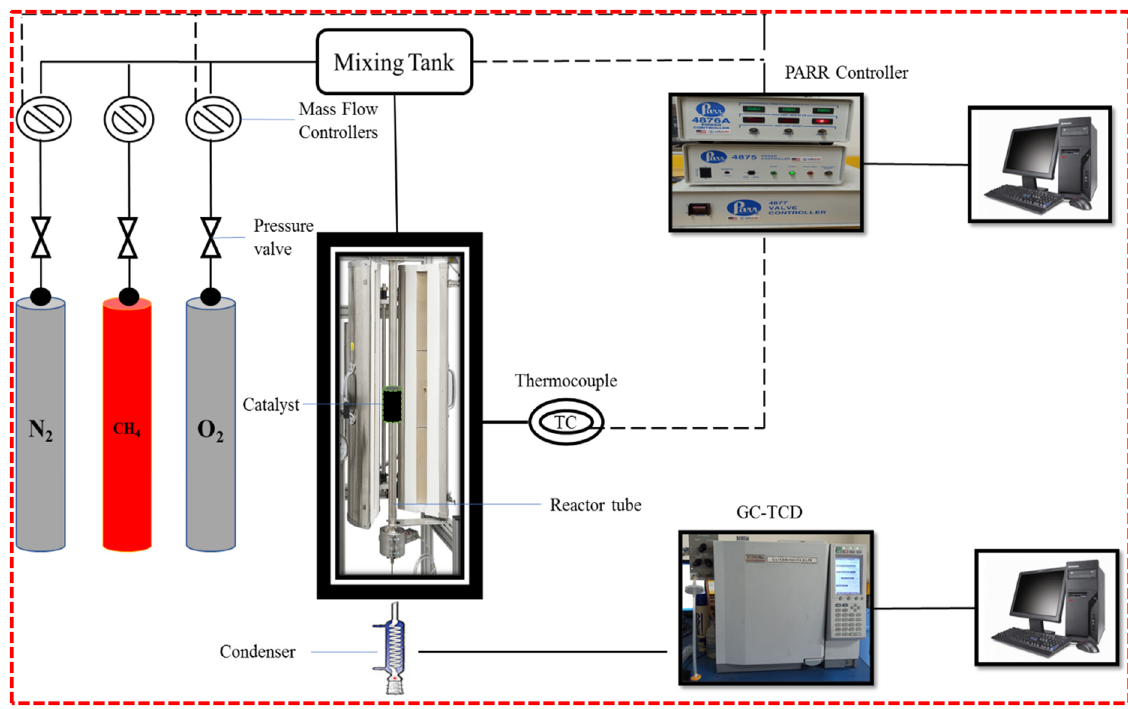
Figure 12. Experimental setup for POM reaction in a fixed bed reactor.